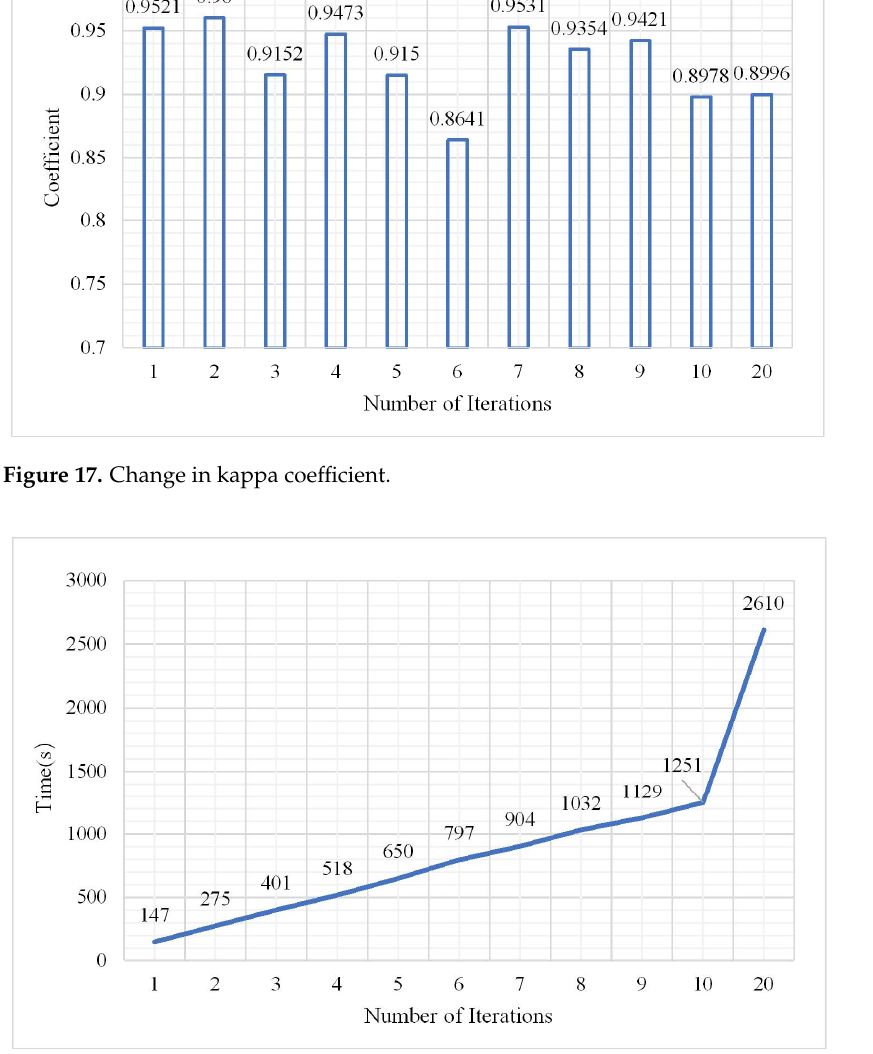
Figure 18. Change in training time.